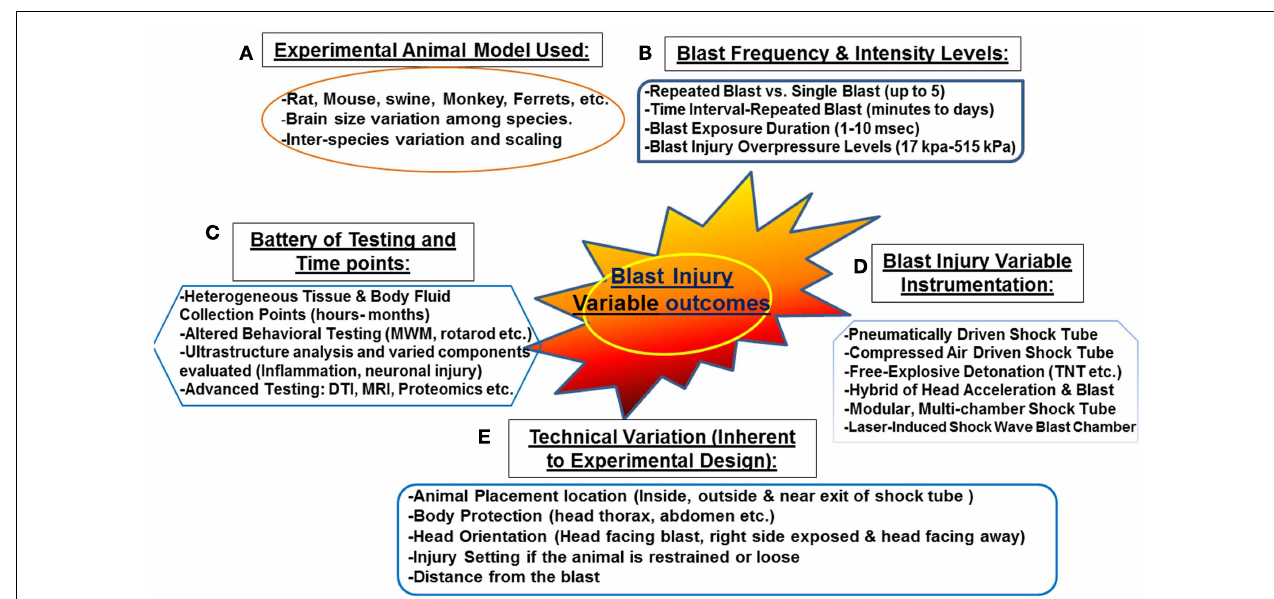
intensity levels ranging from single blast up to five blast with some overpressure intensities reaching 515kPa (C) the heterogeneous selection of biochemical/behavioral testing conducted and the several time points selected (hours to few months) (D) the non-standardized blast and not well characterized blast injury instrumentation (E) technical variation inherent to experimental design related to animal setting, body armor, head protection, and the distance from the blast.These factors contribute to the variable outcome observed in published work in blast injury